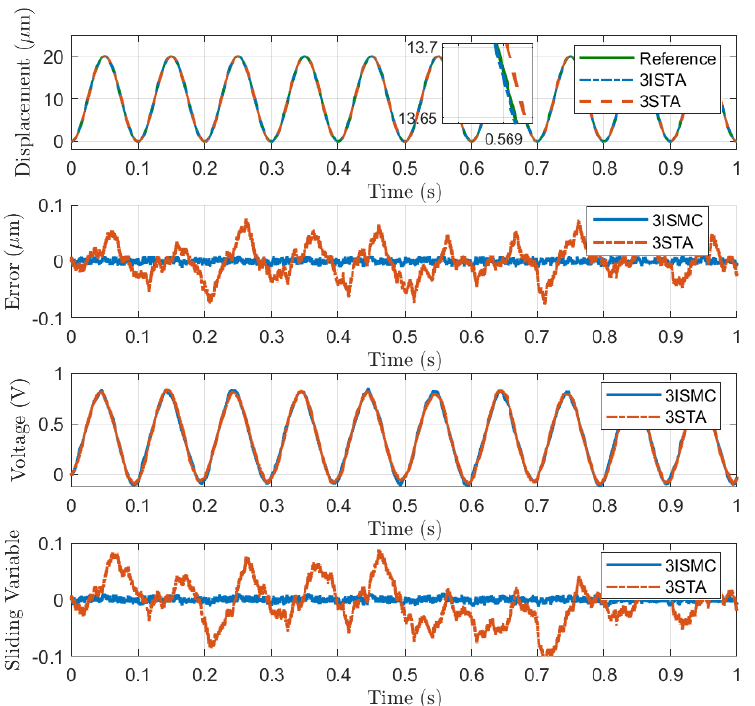
Figure 5. Simulation results of 10Hz sinusoidal trajectory tracking. ( a ) Position tracking results. ( b ) Position tracking error. ( c ) Control inputs. ( d ) Sliding